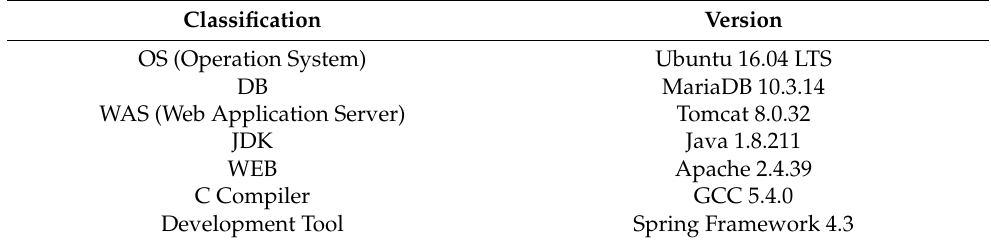
Table 5. Software configuration of the test environment.